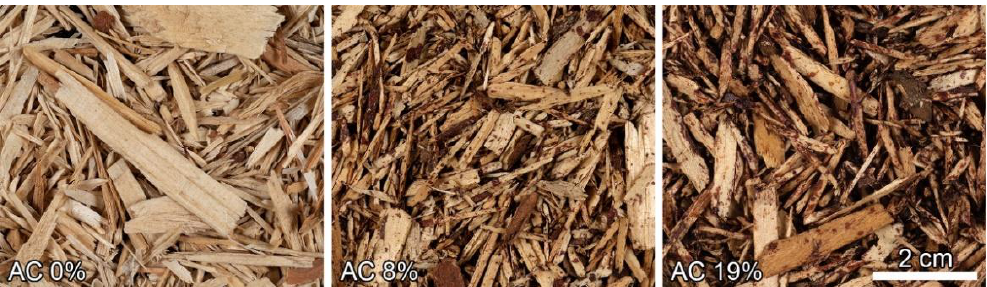
Figure 1. Particle materials (PM) of different adhesive content (AC): PM 1 (AC 0%), PM 2 (AC 8%), PM 3 (AC 19%).